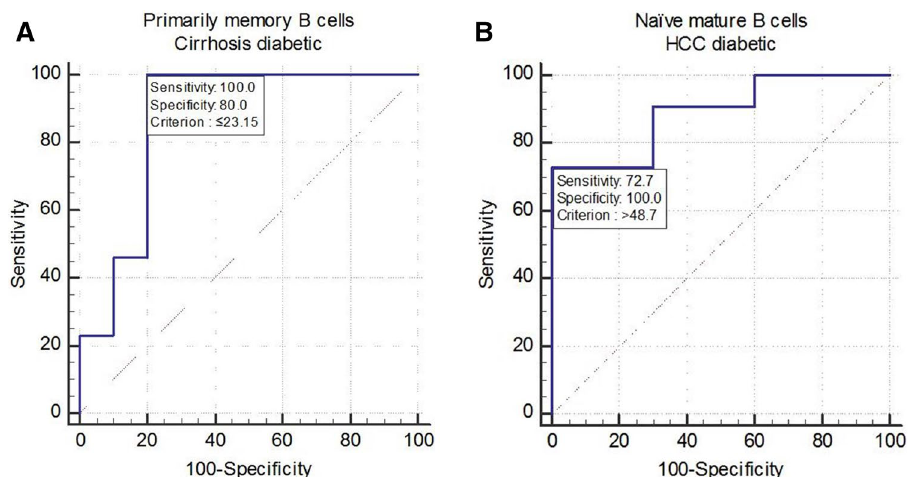
Figure 4. Receiver operating characteristic (ROC) curve of ( A ) CD19 + CD24 + CD38 − primarily memory B cells and ( B ) CD19 + CD24 int CD38 int naïve mature B cells, for prediction of liver cirrhosis and hepatocellular carcinoma, respectively, in diabetic chronic hepatitis C